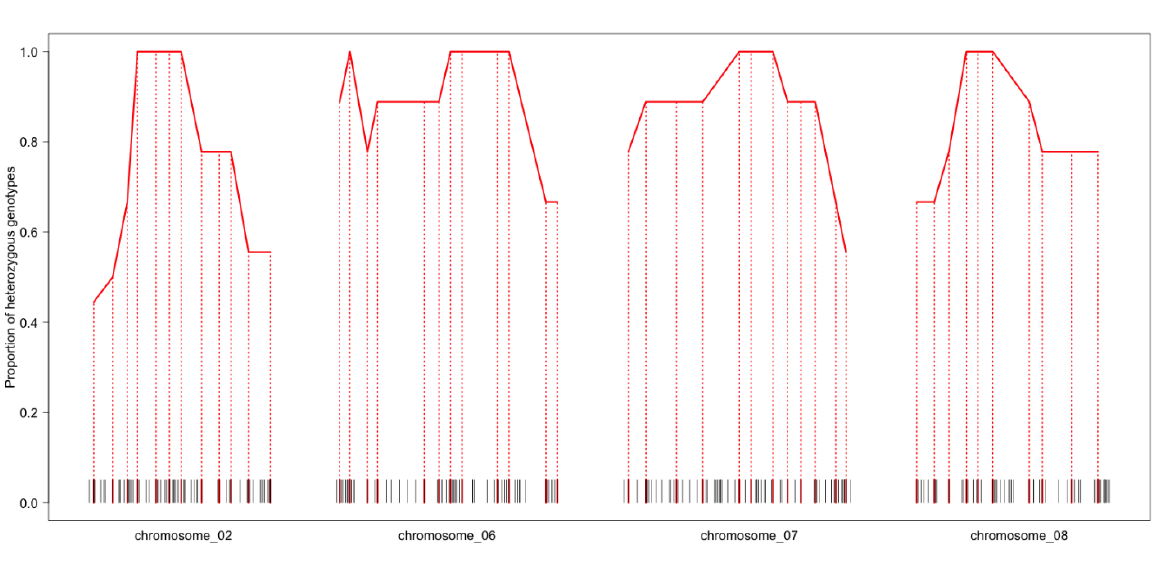
Figure 2: Proportion of heterozygous females (out of nine) for each genotyped SNP marker. The results are only shown for the 4 chromosomes for which a higher number of markers were genotyped. The black segments on the x axis are indicative of the genetic position of all the markers of the genetic map (Benoist et al., 2020a) and the red segments with the dotted lines correspond to the positions of the markers genotyped in this study. The occurrence of homozygous and heterozygous states along the chromosomes is congruent with a mechanism similar to automixis. Given the metacentric nature of C. typhae chromosomes (C. Bressac, personal communication), the observation of 100% heterozygosity in the central part of the chromosomes suggests that diploidy is either maintained by the suppression of the first meiotic division or restored through central fusion and is indicative of the position of each chromosome's